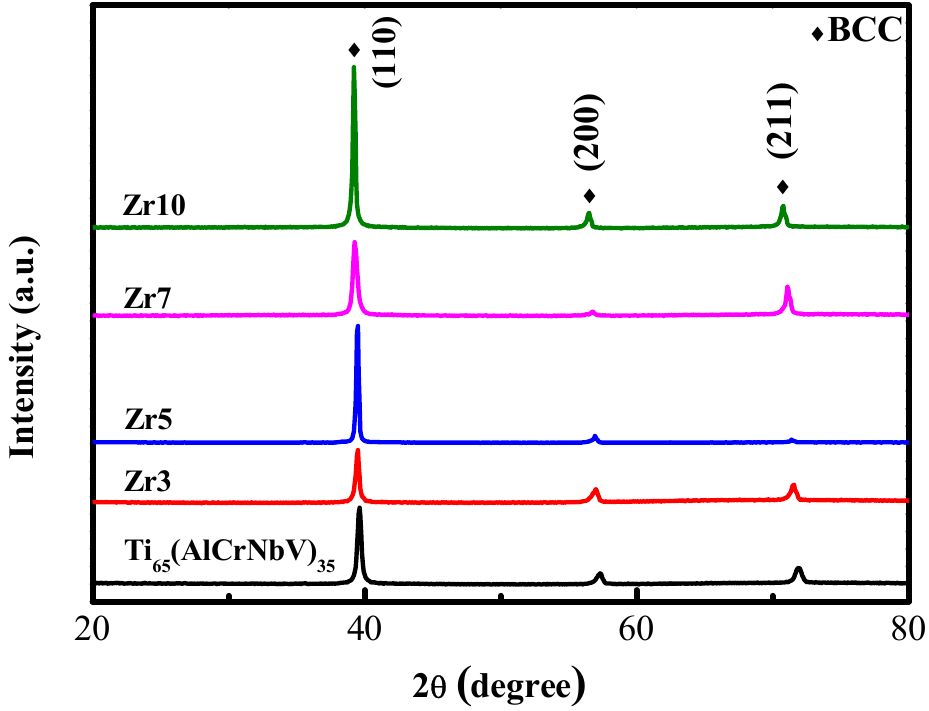
Figure 1. The XRD patterns of the as-cast Ti 65 (AlCrNbV) 35 and Ti 65 (AlCrNbV) 35-x Zr x (x = 3, 5, 7, 10) MEAs.